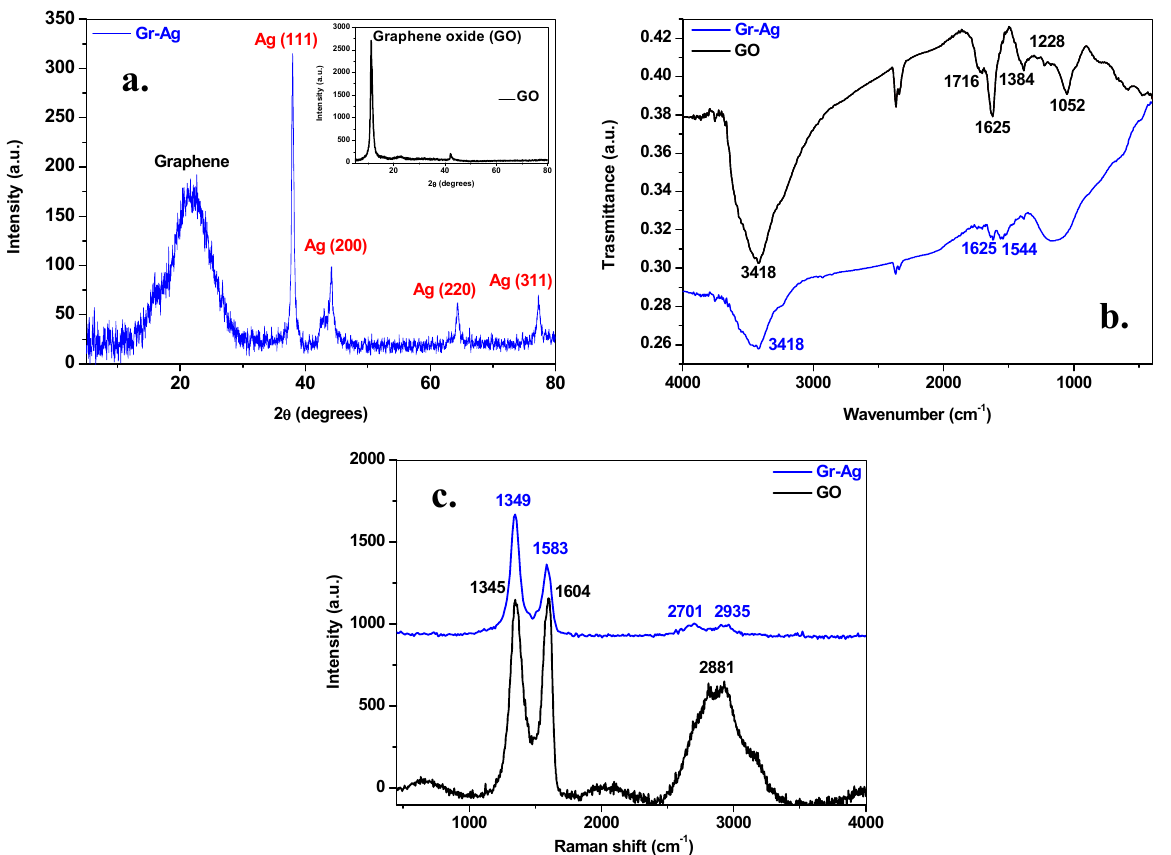
Figure 1. The XRD pattern of Gr-Ag (5 wt% Ag) hybrid material revealing the characteristic peaks of graphene and silver ( a ); Inset: the XRD pattern of graphene oxide (GO); The FTIR spectrum of GO (black line) and Gr-Ag (5 wt% Ag; blue line) ( b ); Raman spectrum of GO (black line) and Gr-Ag (5 wt% Ag; blue line) ( c ).